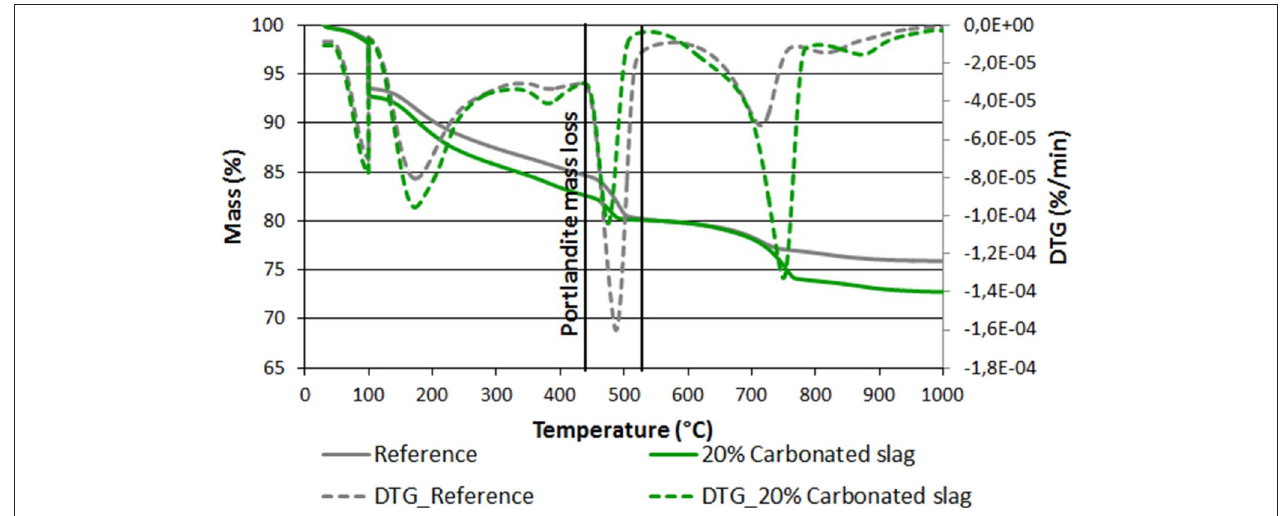
FIGURE 13 | TGA curves of reference paste and paste with 20% of carbonated slag at 28